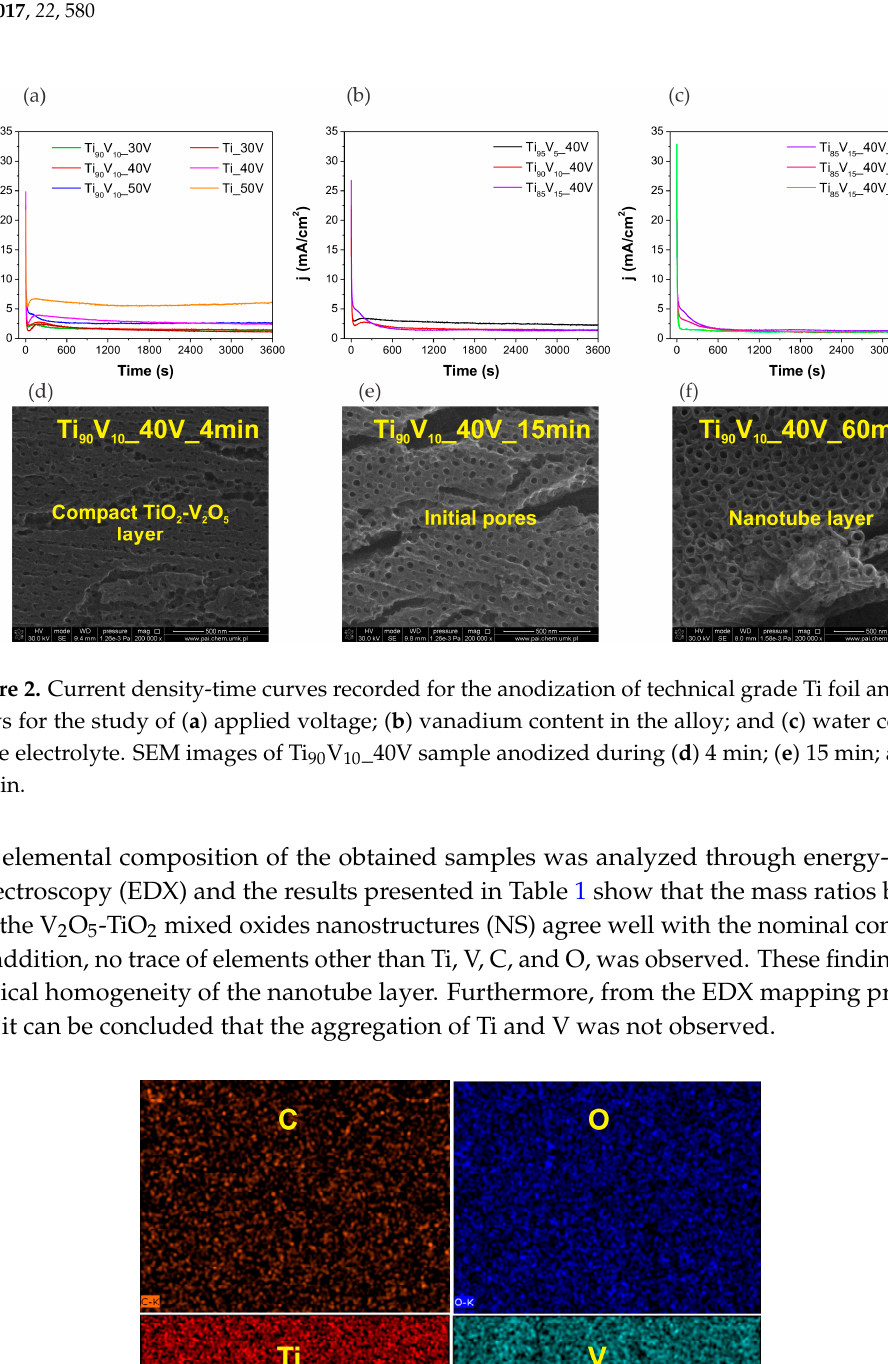
Figure 1. Top-view and cross-sectional scanning electron microscopy (SEM) images of pristine TiO 2 nanotubes (NTs) and Ti-V anodized alloys.